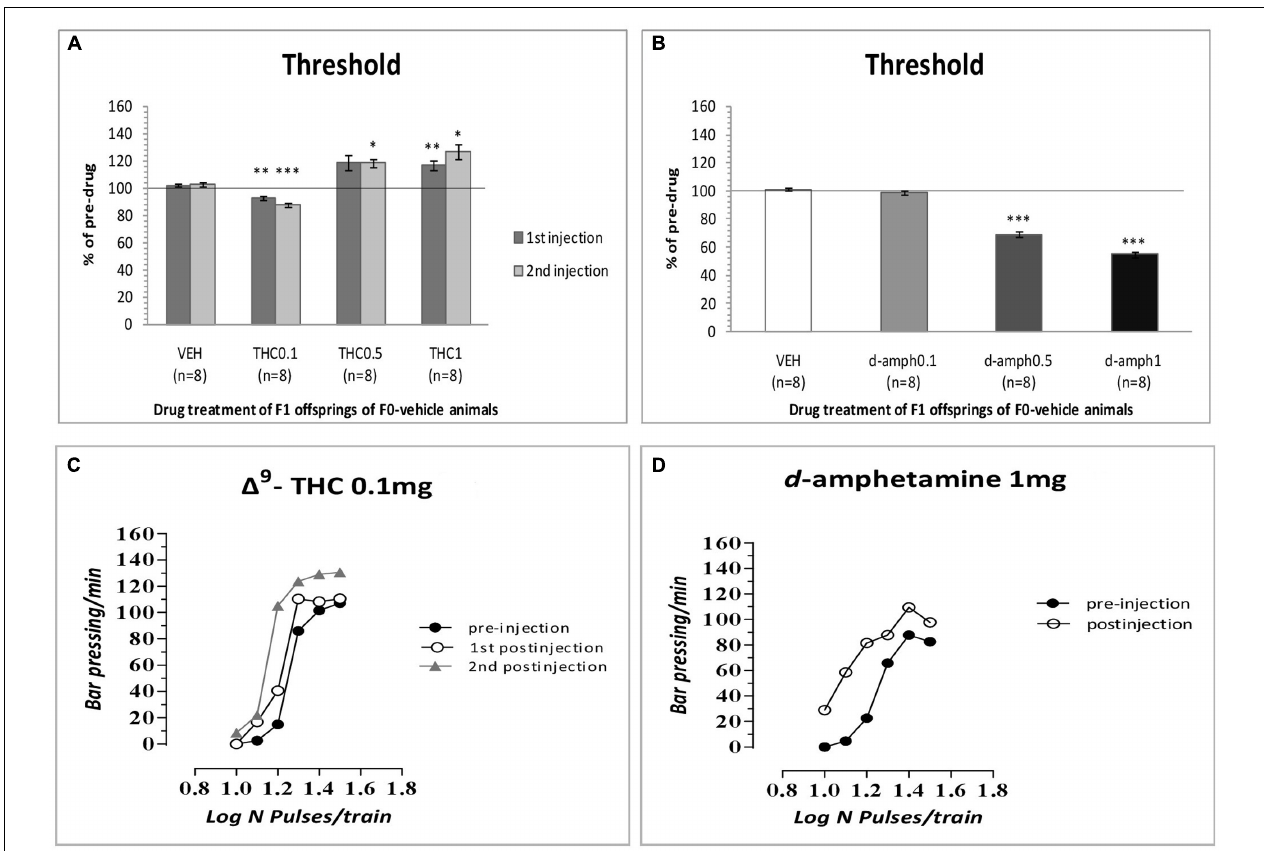
FIGURE 1 | Changes in intracranial self-stimulation (ICSS) threshold expressed as percentage of predrug values, following (cid:49) 9 -THC (0, 0.1, 0.5, and 1 mg/kg, i.p.) (A) and d -amphetamine (0, 0.1, 0.5, and 1 mg/kg, i.p.) (B) administration in F1 offspring of F0-vehicle animals. Vertical bars represent the means ± SEM. The asterisk ( ∗ ) signifies an ICSS threshold significantly different from the respective control group (vehicle), ∗ p < 0.05, ∗∗ p < 0.01, ∗∗∗ p < 0.001. (C,D) : Rate-frequency functions (rate of lever pressing as a function of stimulation frequency) taken from representative drug naïve animals (i.e., F1 of F0-VEH animals). Each plot represents data from a single animal under predrug and drug conditions ( C : (cid:49) 9 -THC0.1 mg/kg, D : d -amphetamine 1 mg/kg). Rate frequency functions were obtained by logarithmically decreasing the frequency of the stimulation pulses from a value that sustained maximal lever pressing to one that failed to sustain lever pressing. Both (cid:49) 9 -THC and d -amphetamine caused parallel leftward shifts in the rate-frequency function.